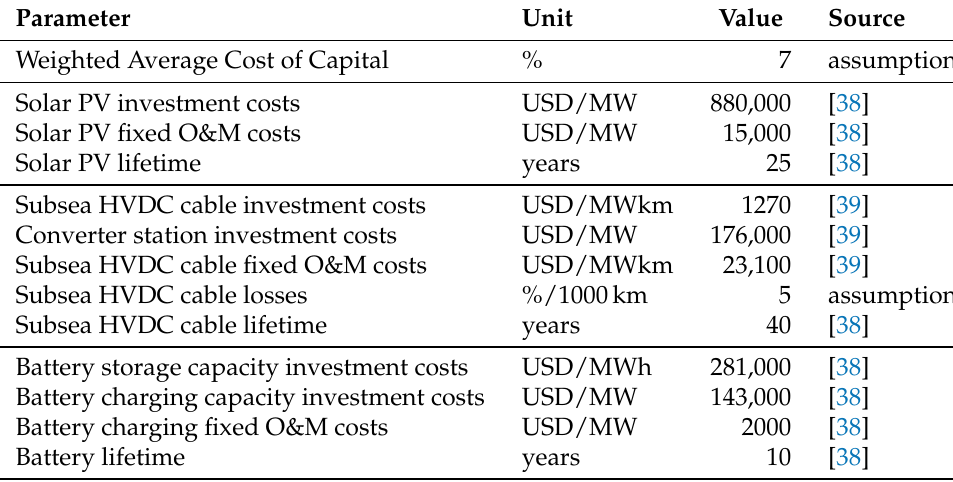
Table A1. Major techno-economic assumptions of the urbs model.